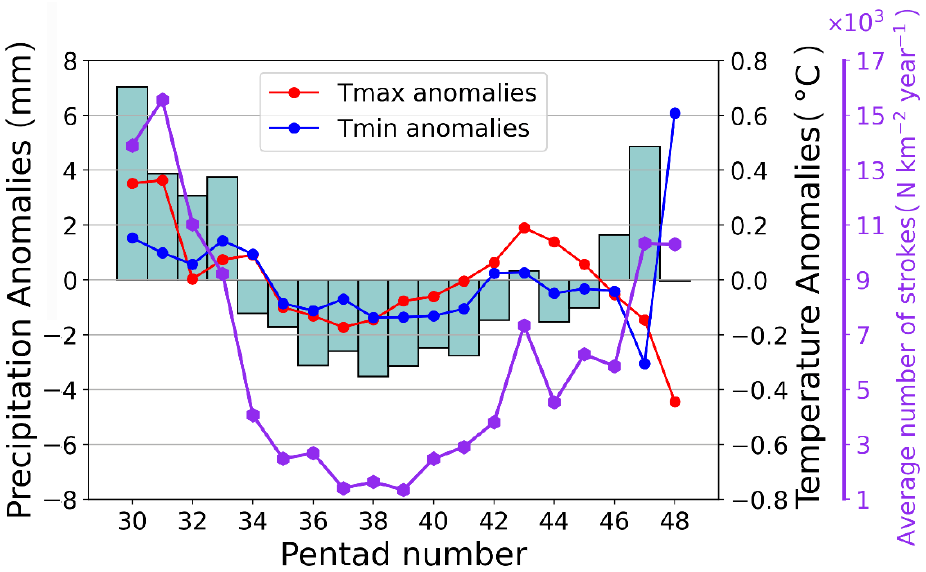
Figure 7. Lightning density, precipitation and extreme temperature anomalies at a single grid region (circa ~225 km 2 , near 11° N, 86° W) located between La Cruz (Costa Rica), and San Juan del Sur (Nicaragua). Data from ERA5 (precipitation, extreme temperatures) and WWLLN (lightning den- sity) for the period 2012–2020. (https://climatedataguide.ucar.edu/climate-data/era5-atmospheric- reanalysis, accessed on 12 May 2021).